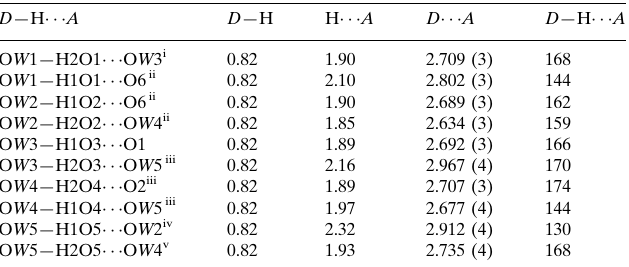
Hydrogen-bond geometry (A˚ , (cid:3)